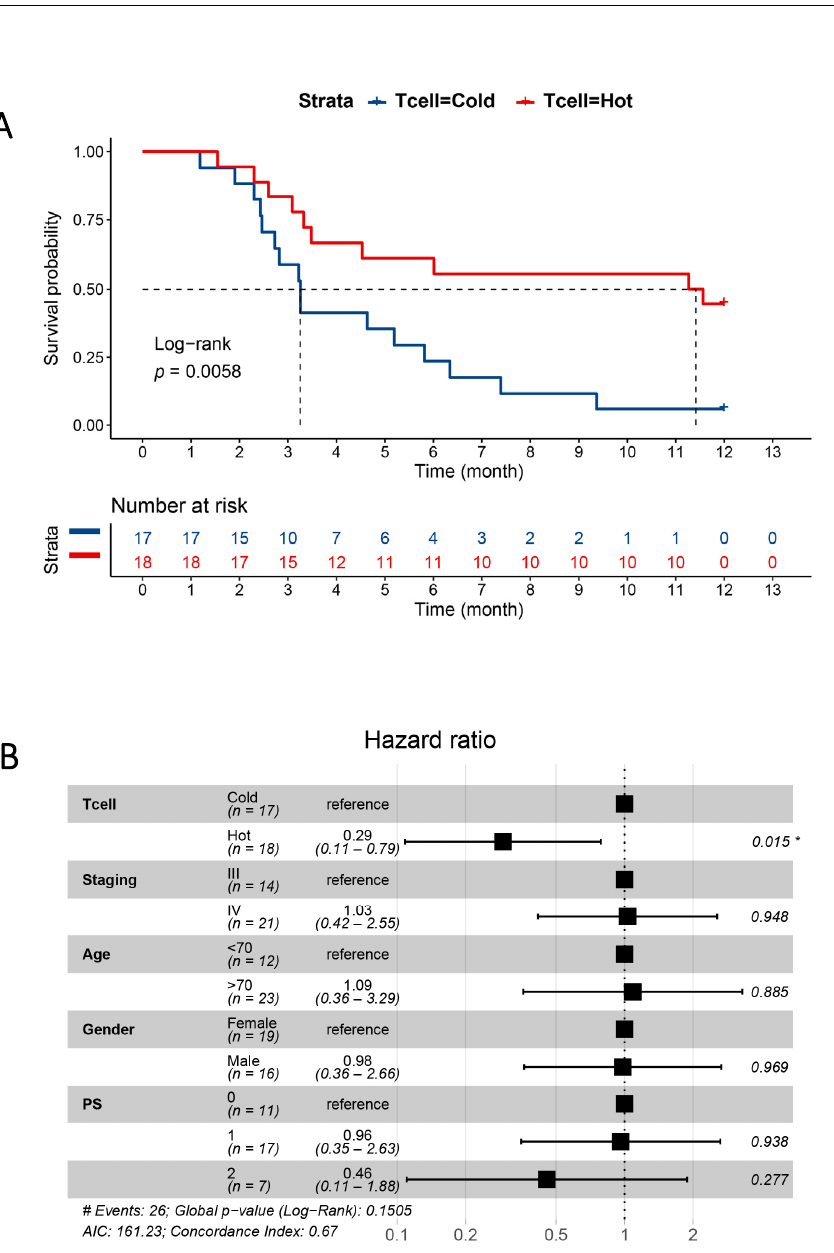
Figure 3. The association between progression-free survival (PFS) and the pretreatment plasma protein signature. ( A ) Kaplan–Meier PFS curves based on hot and cold T-cell activation signatures. A log rank test was performed to compare the two groups. ( B ) Multivariate Cox regression analysis of PFS in the key subgroups. The hazard ratio, 95% confidence interval, and p -value for each analysis are displayed in the plot. (* p ≤ 0.05, PS—performance status.).